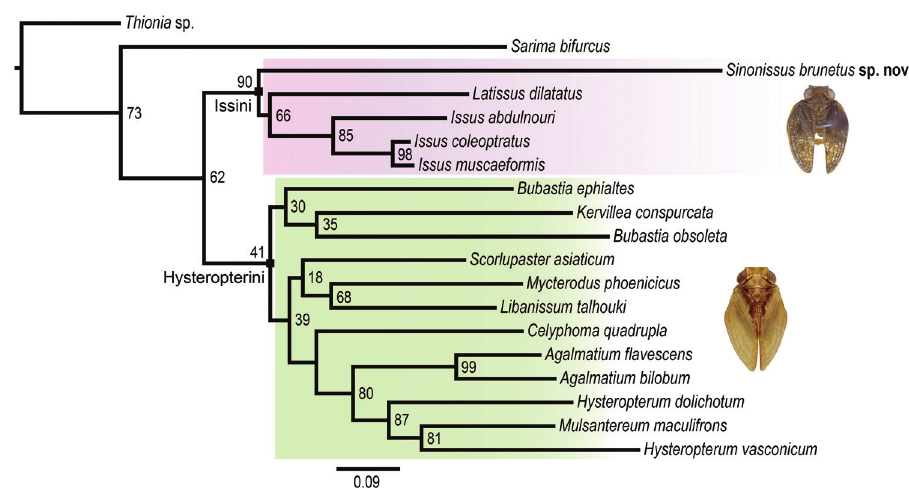
Figure 19. Maximum likelihood tree of Issinae based on COI sequence with Thionia sp. (Issidae Thioni- inae) and Sarima bifurcus (Issidae, Hemisphaeriinae) as outgroup to test to position of Sinonissus gen. n. in the classification and phylogeny of Issidae. Node values denote ultrafast bootstrap